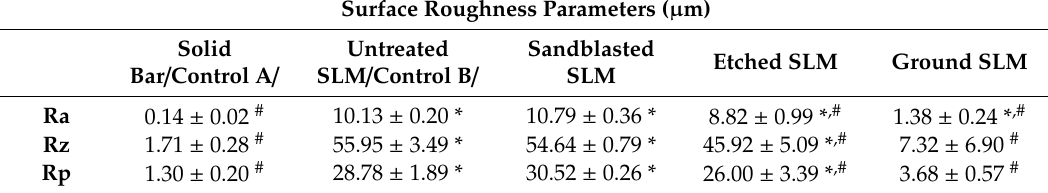
Table 2. Surface roughness parameters: Ra, Rz, Rp of surface-modified titanium specimens measured by profilometer (n = 5; data are the means ± SD; *significantly different from control A (p < 0.05); #significantly different from control B (p < 0.05)).